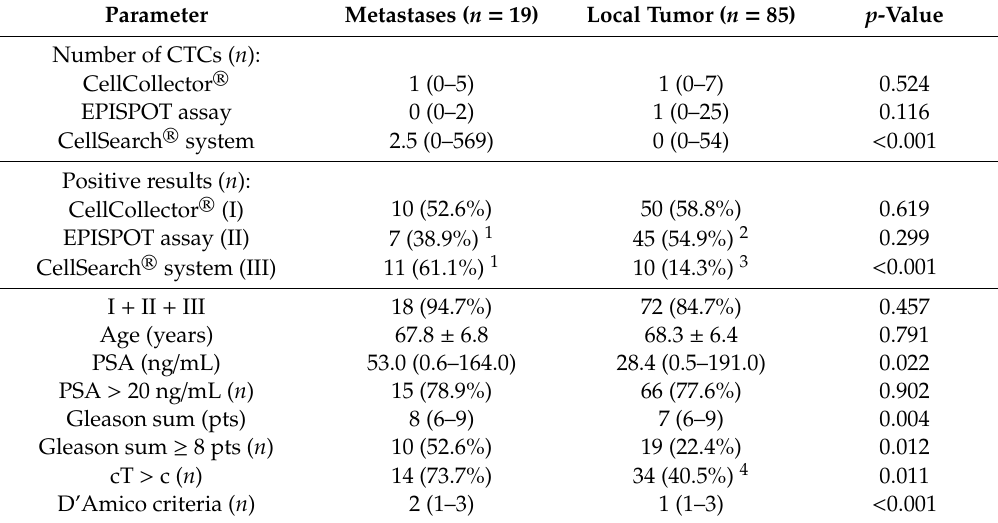
Table 4. Characteristics of patients with and without distant metastases of prostate